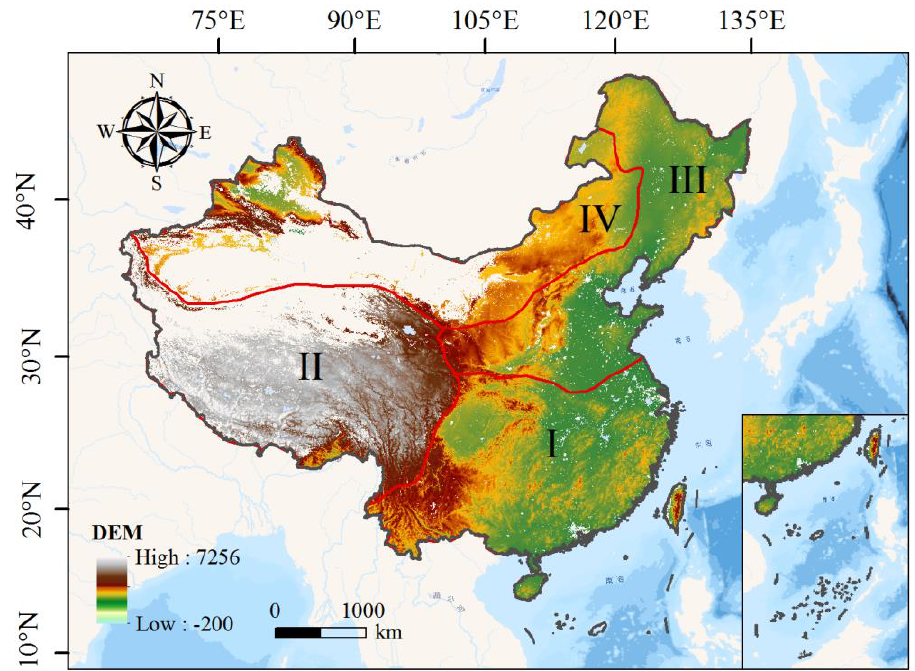
Figure 1. Spatial distribution of DEM elevation maps in China. I, II, III, and IV represent the southern region, the Qinghai–Tibet region, the northern region, and the northwestern region,